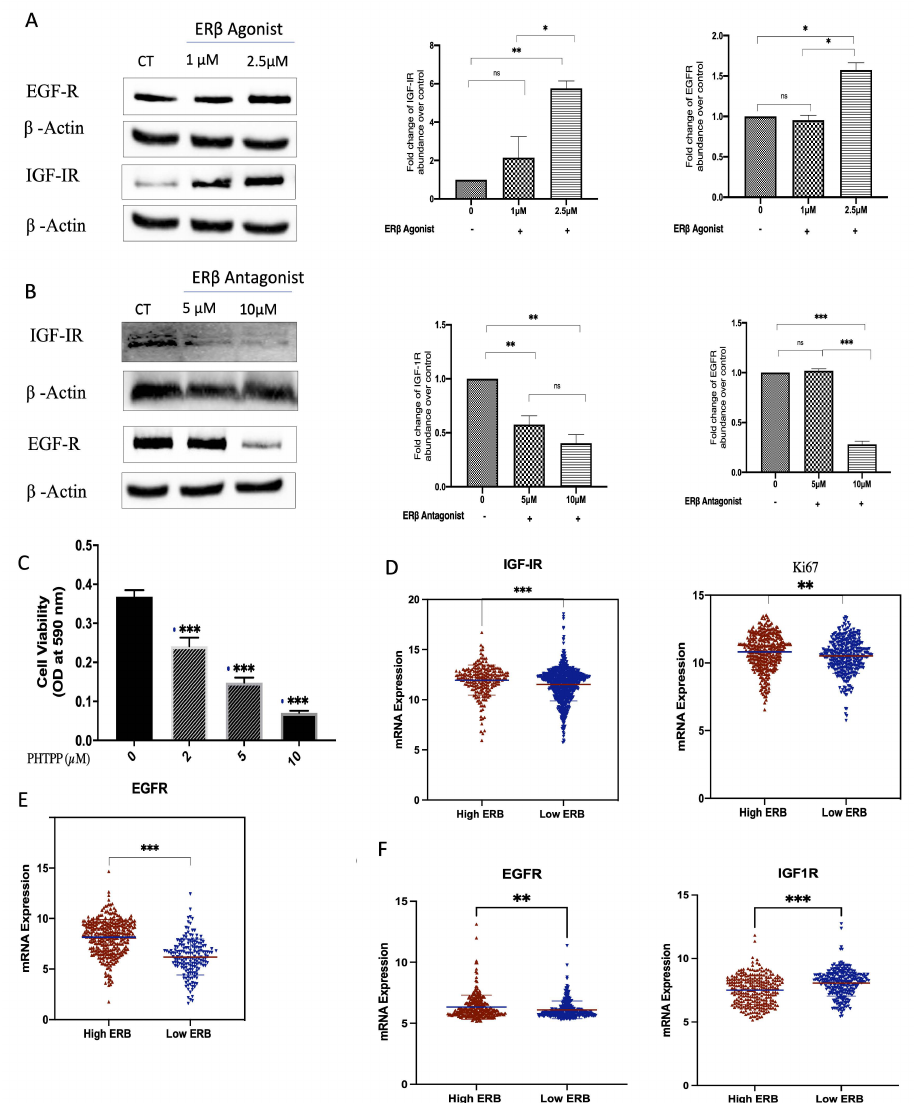
Figure 6. Effects of selective ER- β agonist and antagonist treatment on levels of IGF-IR and EGFR in MDA-MB-231. MDA-MB-231 were treated with an ER- β agonist or antagonist ( A , B ) for 24 h and were immunoblotted for IGF-IR and EGFR. GAPDH was used as a loading control, and respective quantitative densitometry analyses of the blots are shown in MDA-MB-231 cells. ( C )